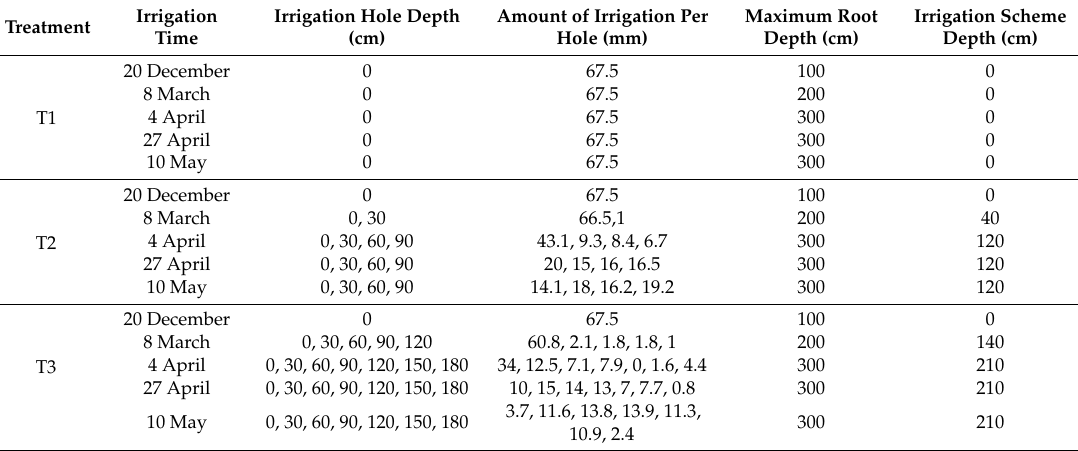
Table 2. The irrigation time, irrigation hole setting, irrigation scheme depth, and irrigation quota of winter